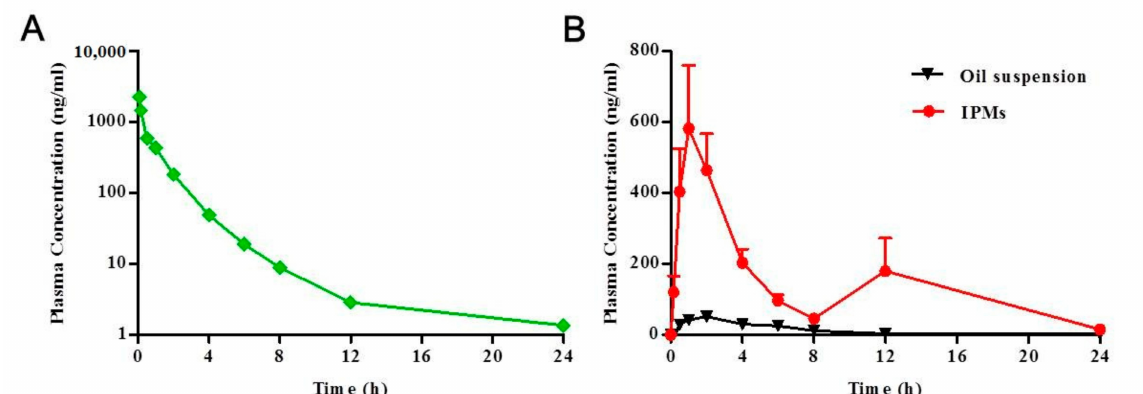
Figure 6. Mean plasma concentration of icaritin versus time profiles following a single injection of icaritin solution at a dose of 2 mg/kg ( A ), and oral administration of IPMs and oil suspensions at a dose of 20 mg/kg ( B ) to beagle dogs. IPMs, icaritin-loaded polymeric